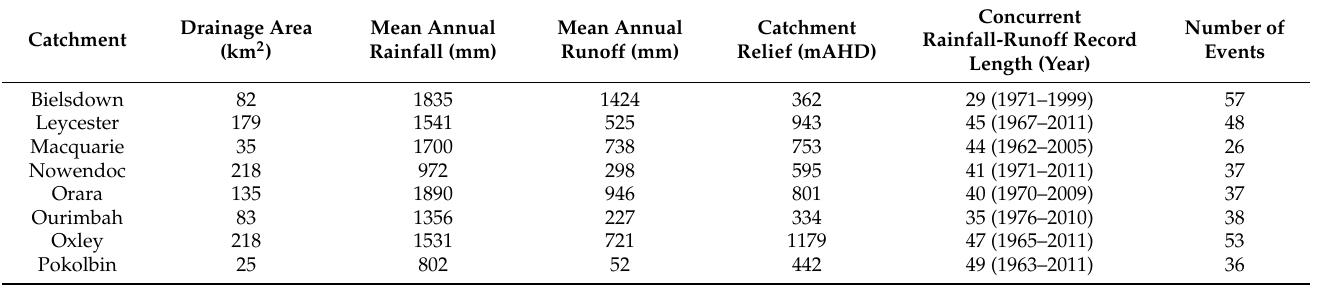
Table 1. Geographic and meteorological catchment characteristics, including data availability for the selected study catchments.